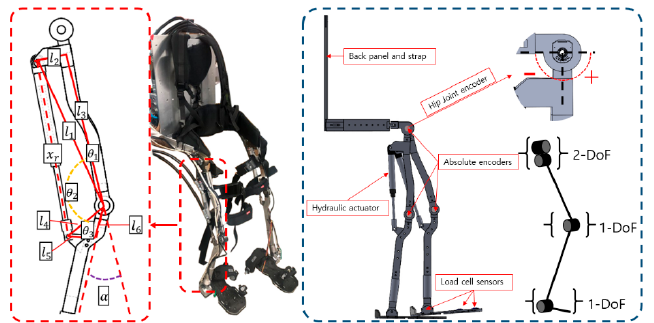
Figure 1. Design of an exoskeleton robot with an electro-hydraulic actuator (EHA) system. DoF: degrees of freedom.